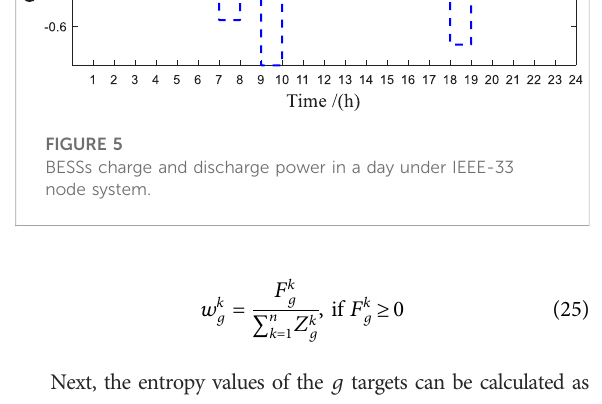
FIGURE 5 BESSs charge and discharge power in a day under IEEE-33 node